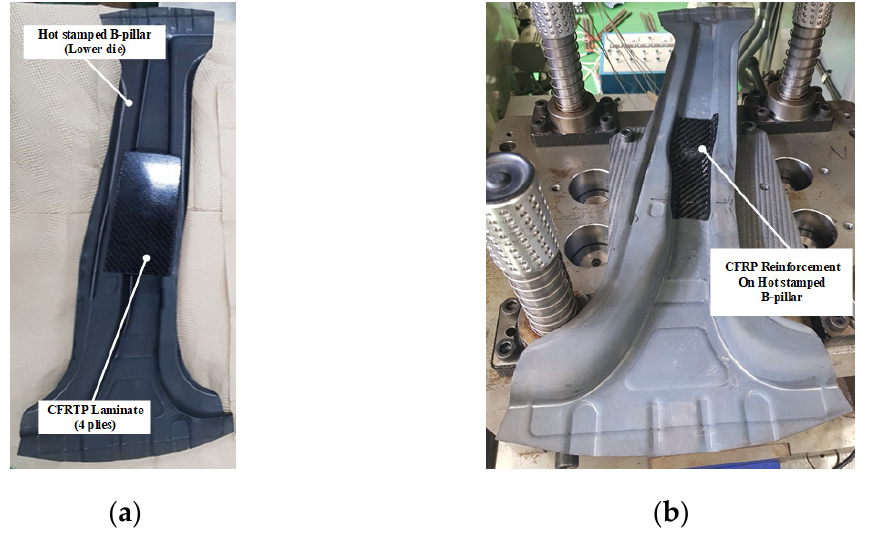
Figure 13. CFRP reinforcement on the hot stamped B-pillar by PCM. ( a ) Before forming. ( b ) After forming.